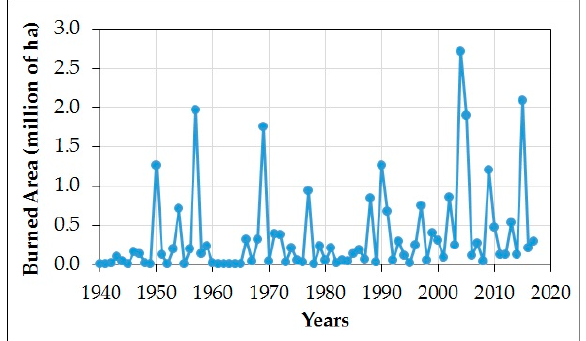
Figure 2. Burned area annual distribution in Alaska for 1940 to 2017, recorded by the Alaska Fire Service (AFS).